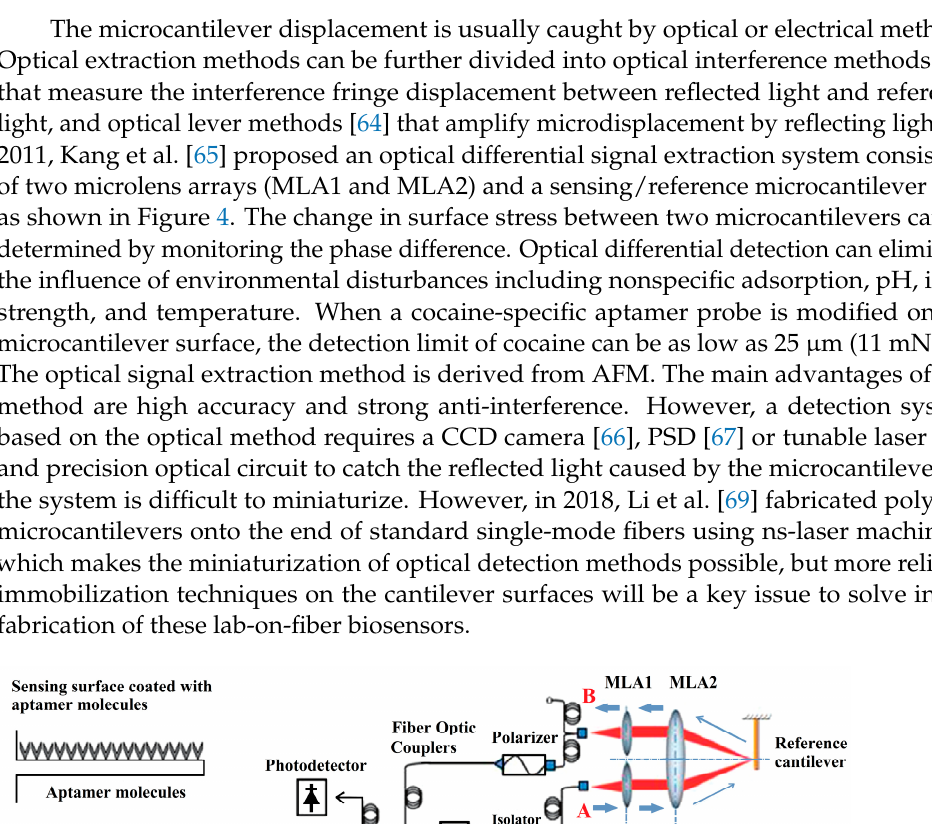
Figure 3. Processes of GNPs combine hybridization information [59].